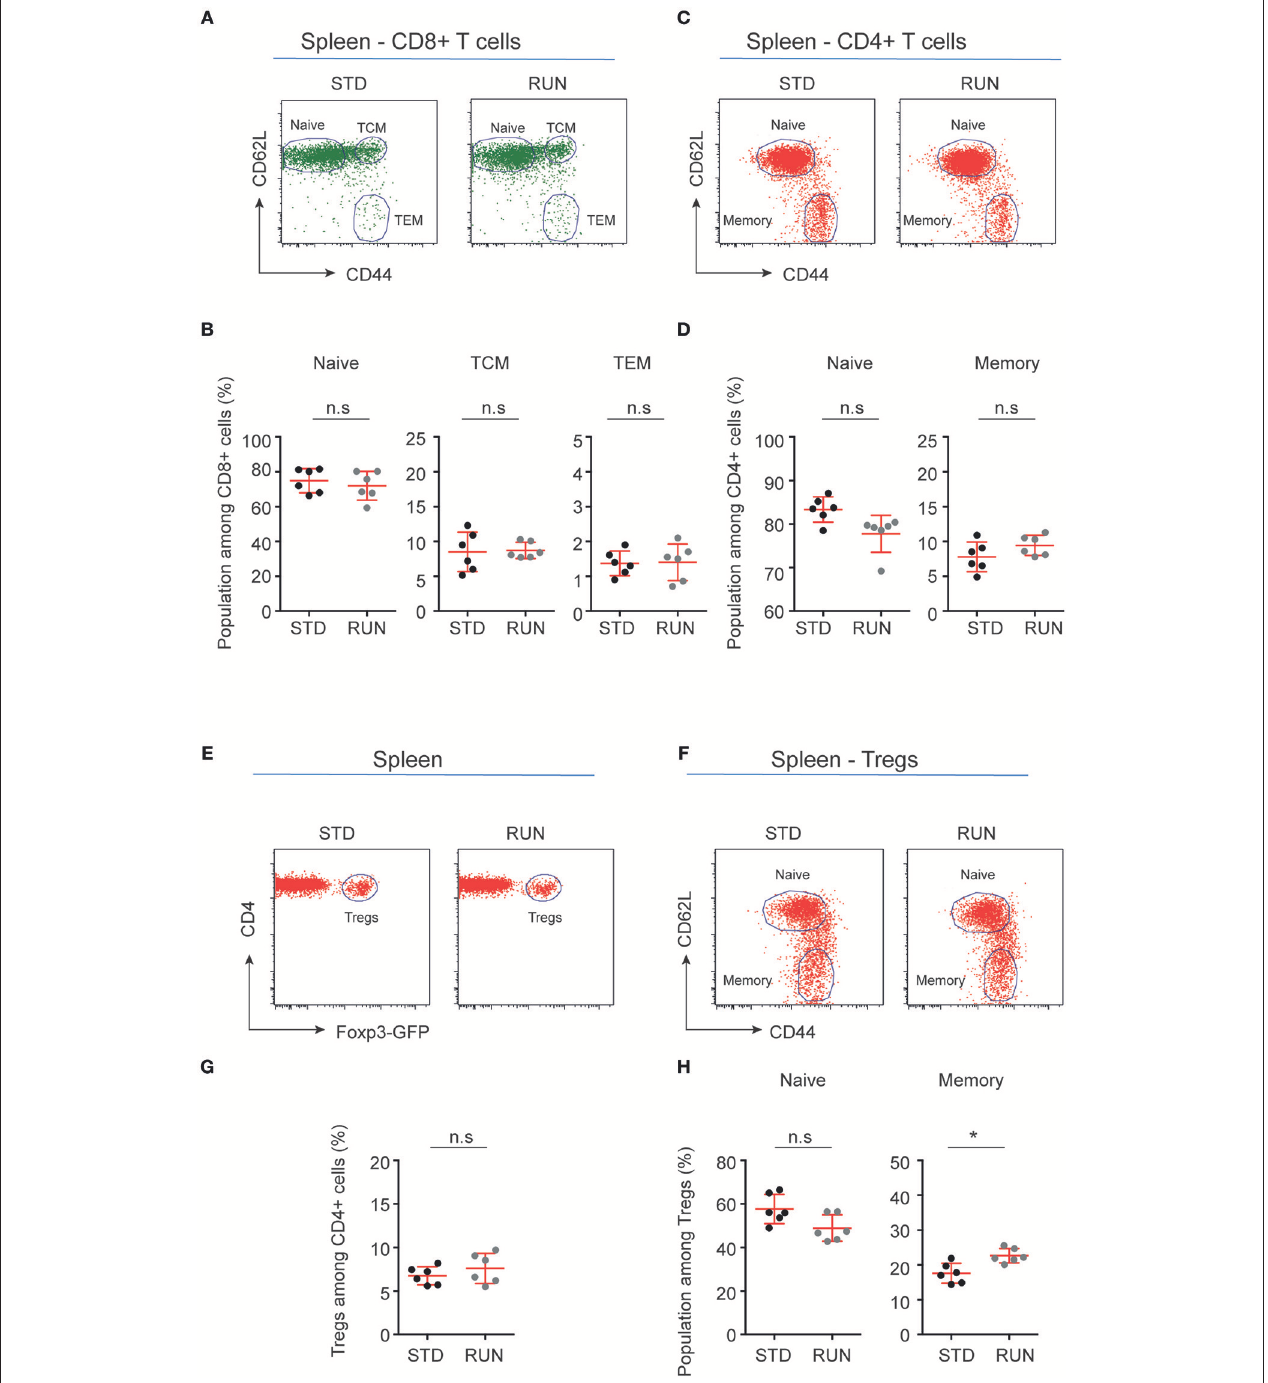
FIGURE 5 | Maturation stages of CD8 + and CD4 + T cells and Tregs in the spleen of standard-housed and exercising mice . (A,C) Representative dot plots of CD62L and CD44 expression on CD8 + (A) and CD4 + (C) T cells in the spleen of mice that were housed under STD or RUN conditions. (B) Composite frequencies of naive, central memory (TCM), and effector memory (TEM) T cells among CD8 + T cells in the spleen. (D) Composite frequencies of naïve and memory T cells among CD4 + T cells in the spleen. (E) Representative dot plots depicting the expression of Foxp3-GFP among gated CD4 + T cells in the spleen of mice that were housed under STD or RUN conditions. (G) Composite frequencies of Foxp3 + Tregs among CD4 + T cells in the spleen. (F) Representative dot plots depicting the expression of the maturation markers CD62L and CD44 on Foxp3 + Tregs. (H) Composite percentages of naive and memory Treg cells in the spleen of STD and RUN mice after 4 days of running. Numbers in dot plots in (B,D,G,H) indicate the percentages of cells within the respective gate. Symbols and horizontal lines indicate individual mice and mean values ± SD, respectively. The level of significance was determined by a two-tailed Mann Whitney test. Data were compiled from two independent experiments. * p <